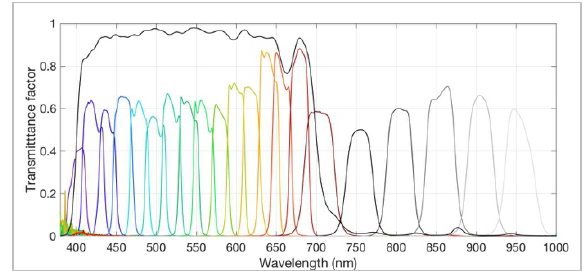
Figure 2. Transmission spectra of VIS and NIR filters used to measure the spectral response of the cameras. The figure includes the transmission of the UV-IR block filter (black), and the figure includes the corrected spectra for the 640, 660, 680 nm (corrected with the transmission of the UV-IR block filter).